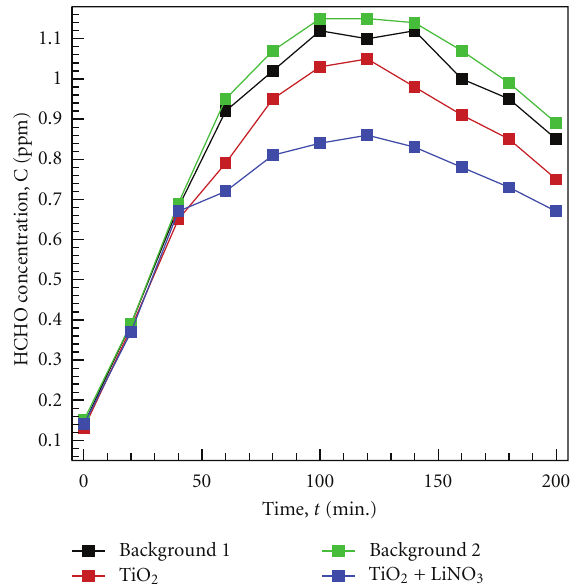
Figure 12: The degradation performance for gaseous formaldehyde under irradiation of visible light lamps at 26 ◦